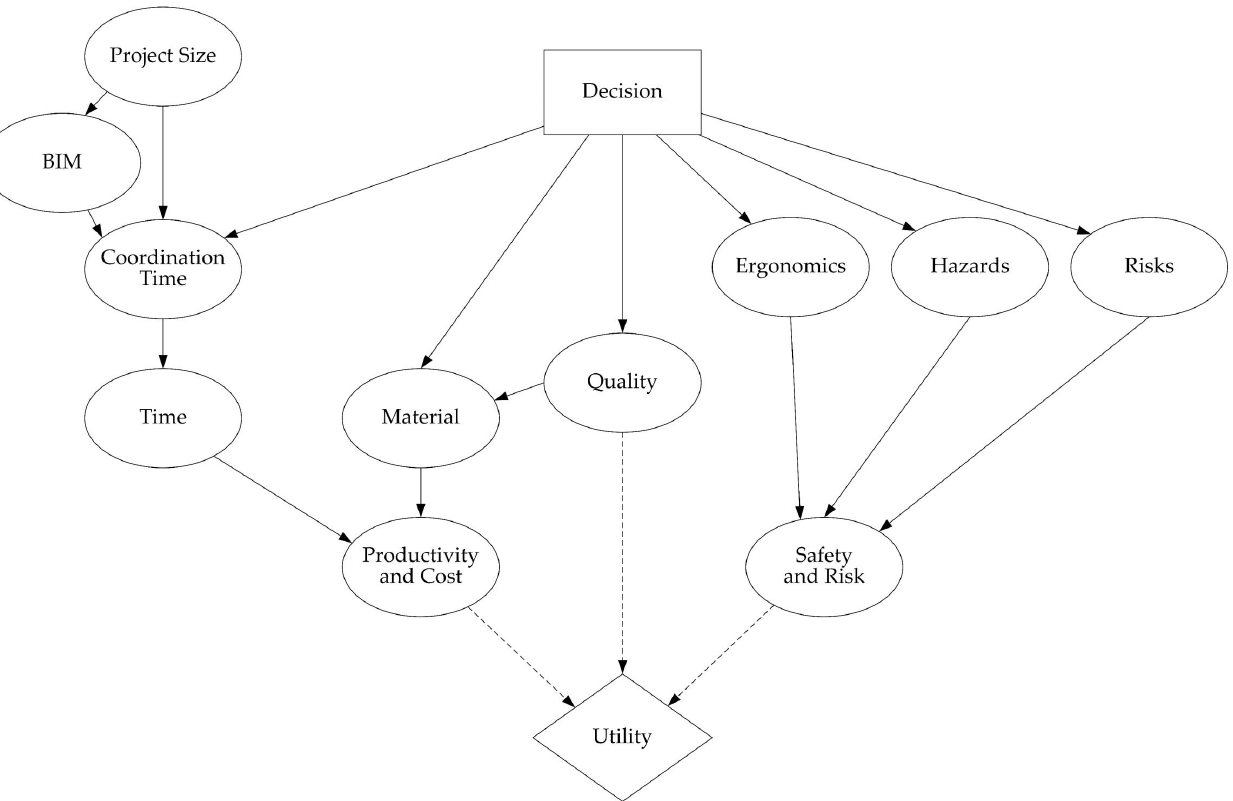
Figure 2. Simplified decision model for UC4—marking and